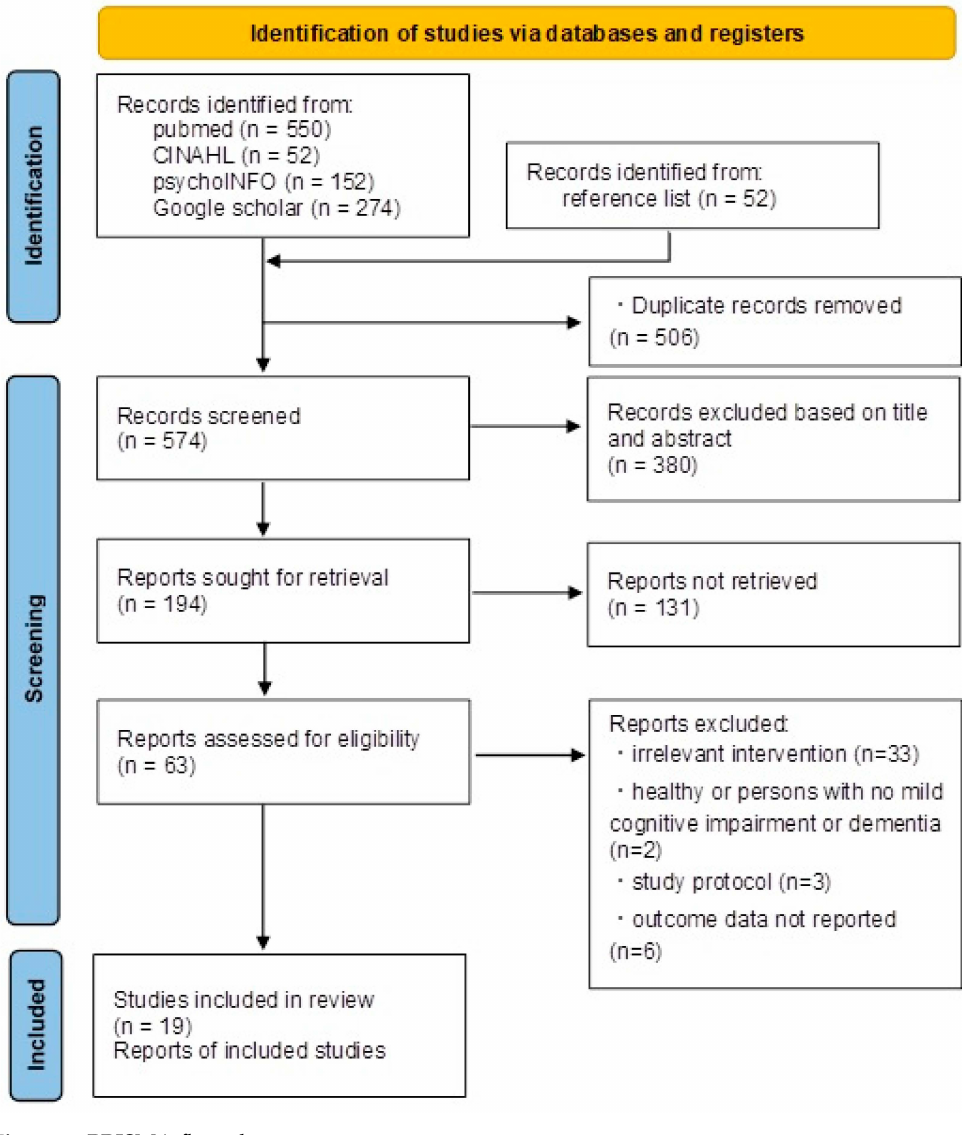
Figure 1. PRISMA flow